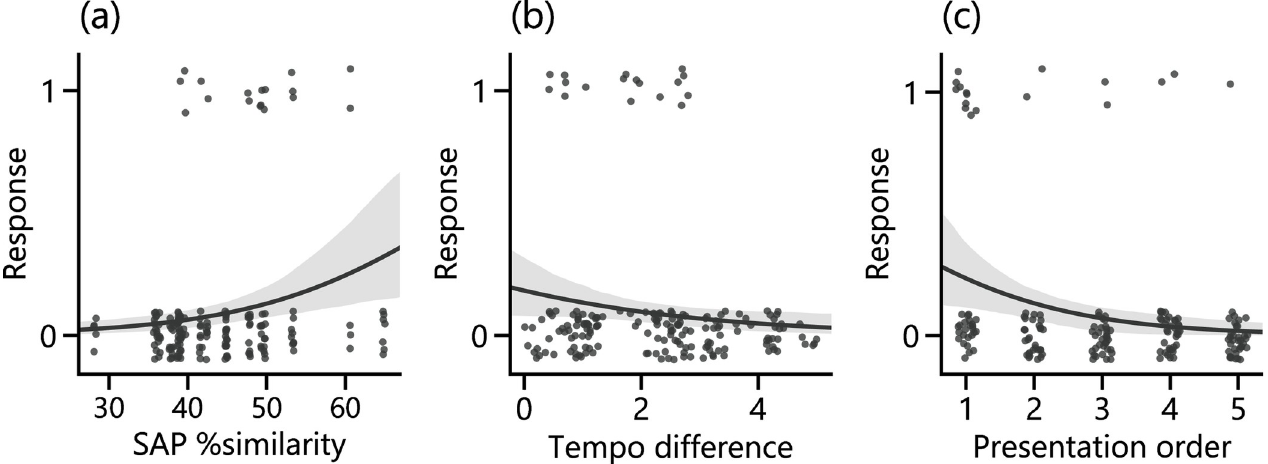
Fig 3. Analysis of song similarity. CSD response was plotted against the (a) acoustical similarity (SAP % similarity), (b) temporal similarity (absolute value of tempo difference) of a given unfamiliar song to the father’s song, or (c) presentation order within a test (1–5). In all the panels, 0 and 1 on the vertical axis means ‘not performed’ or ‘performed’, respectively. Each data point corresponds to one trial. Thus, there are 176 data points from 7 birds in total (17 points are plotted on ‘performed’). The lines and surrounding bands are the logistic regression curve with 95% confidential interval computed by bootstrapping method (iteration n = 1000).